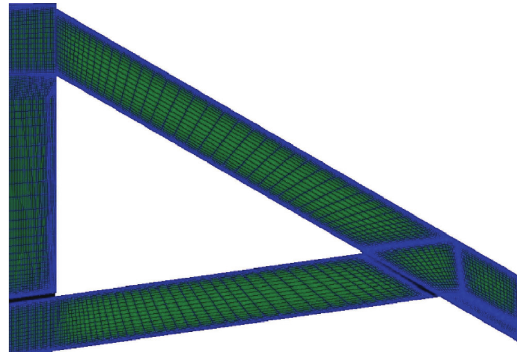
Figure 3: Surface mesh on diamond back wing.